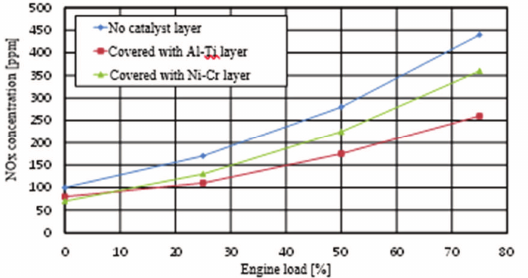
Fig. 3. The concentration of hydrocarbons as a function of engine load